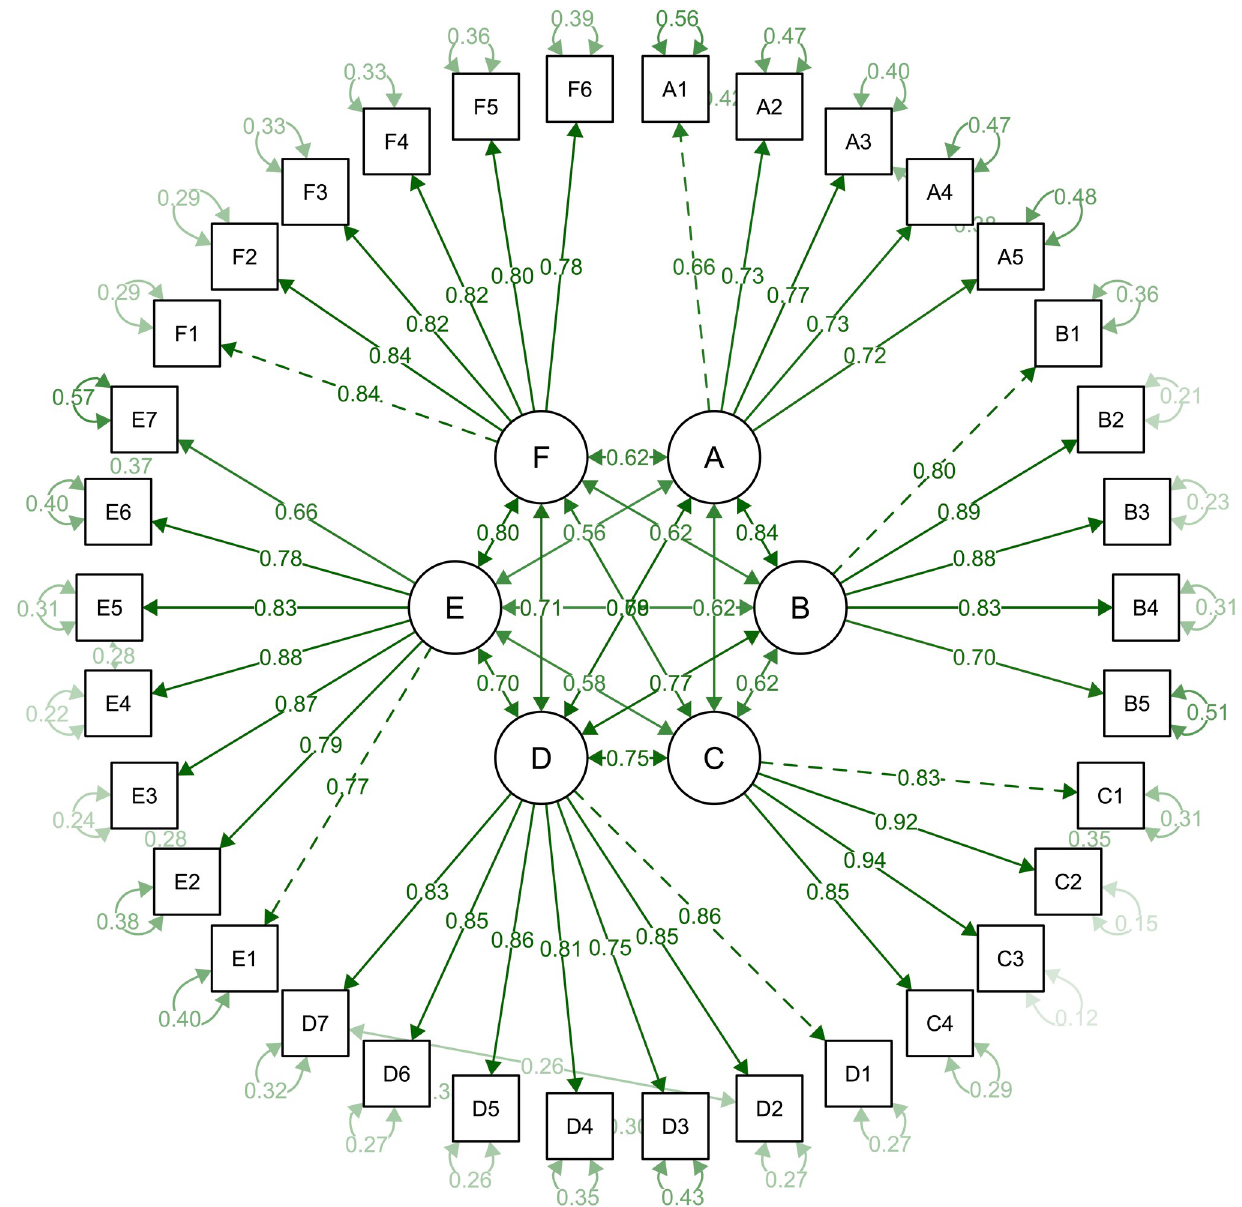
Fig 2. Confirmatory factor analysis for the six-factor model of the VIJS. Factor A: Physical working conditions , Factor B: Work nature , Factor C: Income and other benefits , Factor D: Management policies and managers , Factor E: Relationships with coworkers and customers , Factor F: Learning and advancement opportunities .